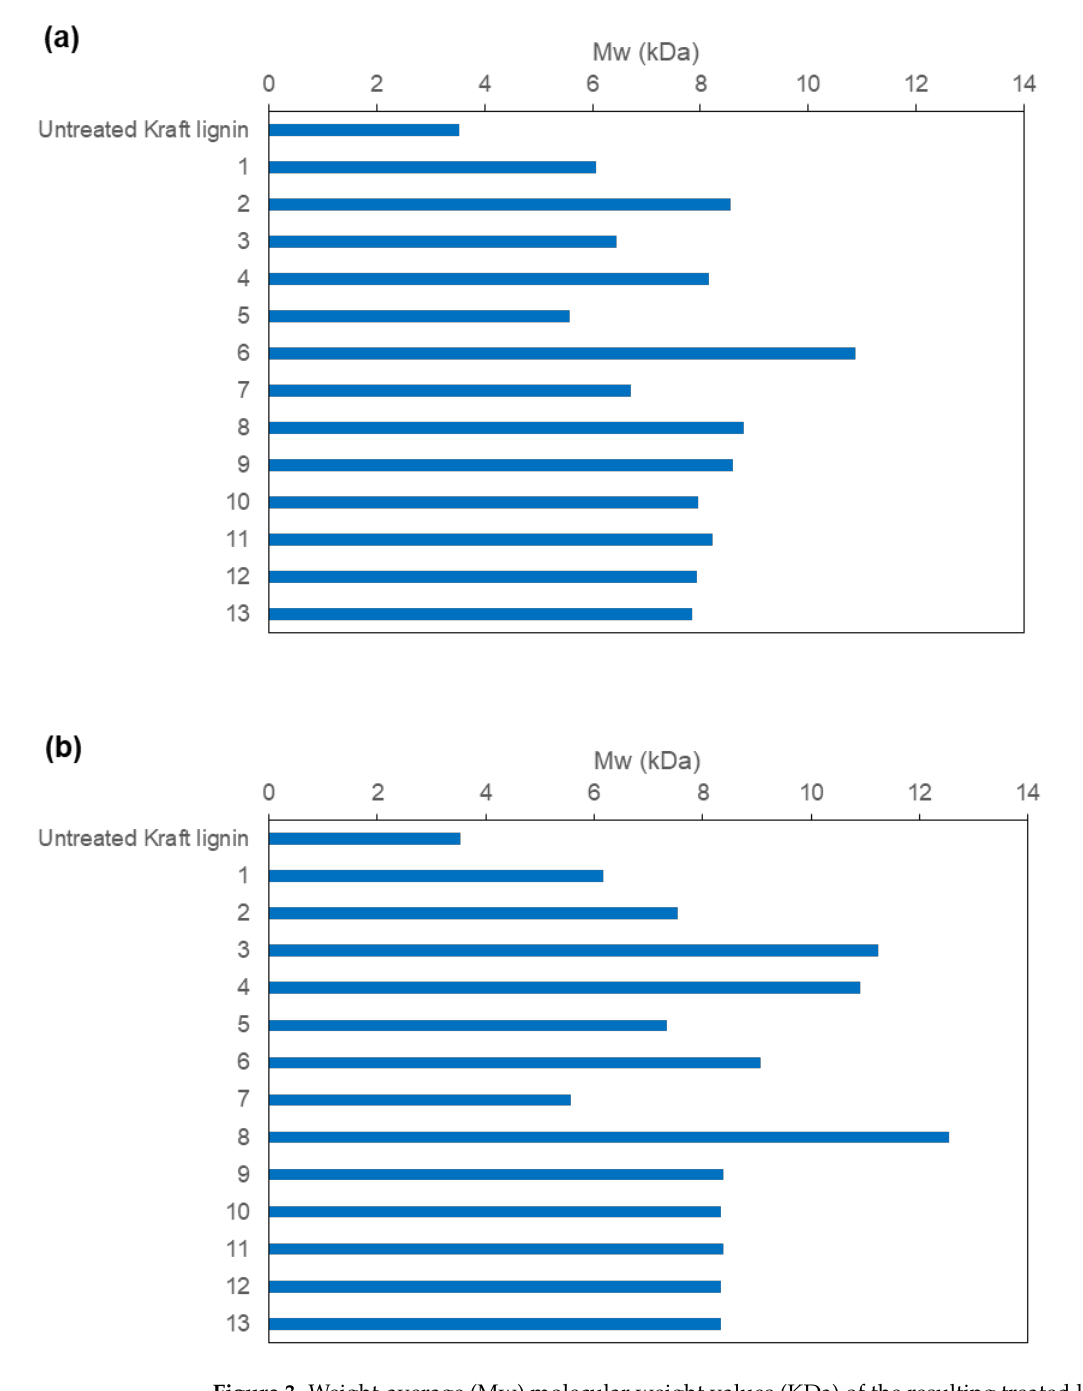
Figure 3. Weight-average (Mw) molecular weight values (KDa) of the resulting treated lignins with MtL ( a ) and SiLA ( b ) laccases (experiments resulting from CCD).